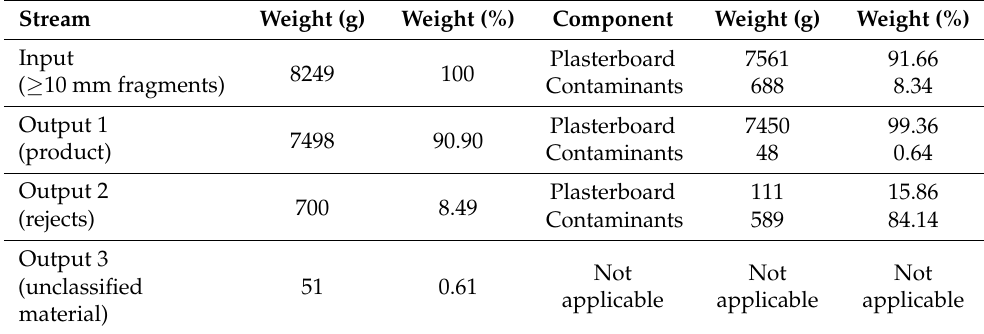
Table 3. Composition of the input and output materials as determined by the HSI-based classification process.